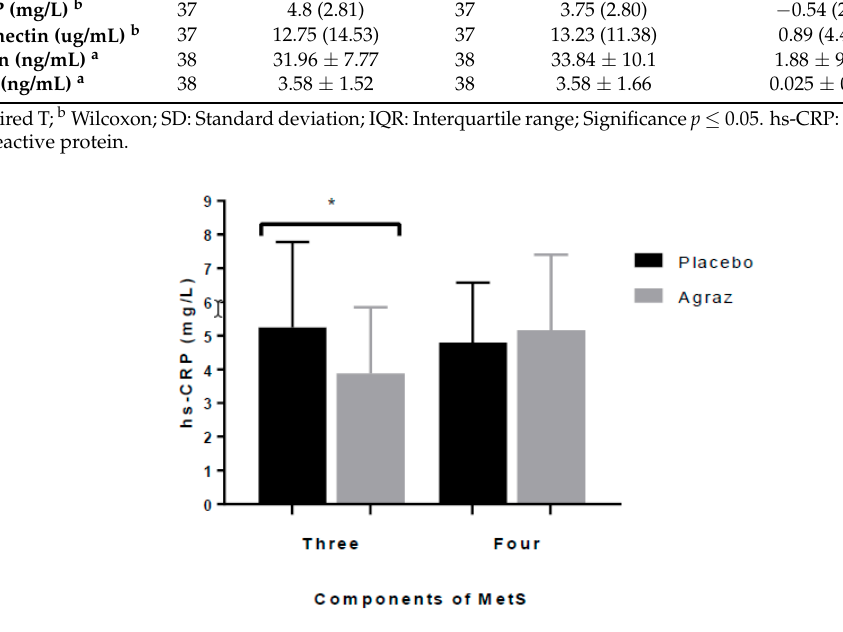
Table 4. Changes in markers of insulin resistance and inflammation in women with metabolic syndrome after agraz consumption compared to placebo.